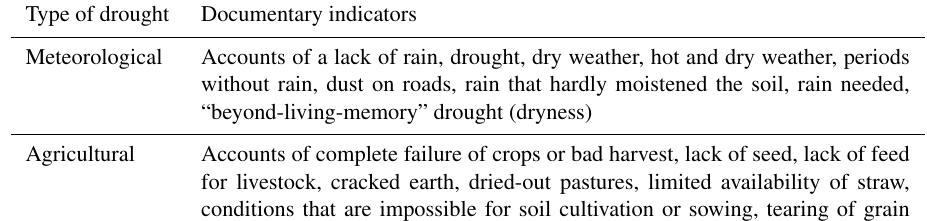
Table 1. Indicators of individual types of drought in documentary evidence. Type of drought Documentary indicators Meteorological Accounts of a lack of rain, drought, dry weather, hot and dry weather, periods without rain, dust on roads, rain that hardly moistened the soil, rain needed, “beyond-living-memory” drought (dryness) Agricultural Accounts of complete failure of crops or bad harvest, lack of seed, lack of feed for livestock, cracked earth, dried-out pastures, limited availability of straw, conditions that are impossible for soil cultivation or sowing, tearing of grain by hand rather than reaping, caterpillars and other pests, damage to crops Hydrological Accounts of the appearance of hunger stones; low water levels in rivers; stand- ing and/or green water in rivers; crossing of otherwise large rivers “barefoot” or with wagons; drying out of springs, wells, fountains, brooks, streams and fish cultivation ponds; lack of water for people and animals; sale of water; water- mills out of operation; cessation of river transport; lack of water for extinguish- ing fires. (Note that many of these indicators require careful interpretation in dry-climate regions of the world where dry seasons are a common part of the hydrological pattern.) Socio-economic Accounts of food shortages, increase of prices (grain and other crops), poverty, debt, distress, famine, requests for tax reduction, administrative measures, raised awareness of witchcraft and other rain-related ritual practices, human mortality, disease, epidemics, emigration, building and forest fires, sale of live- stock at below normal market